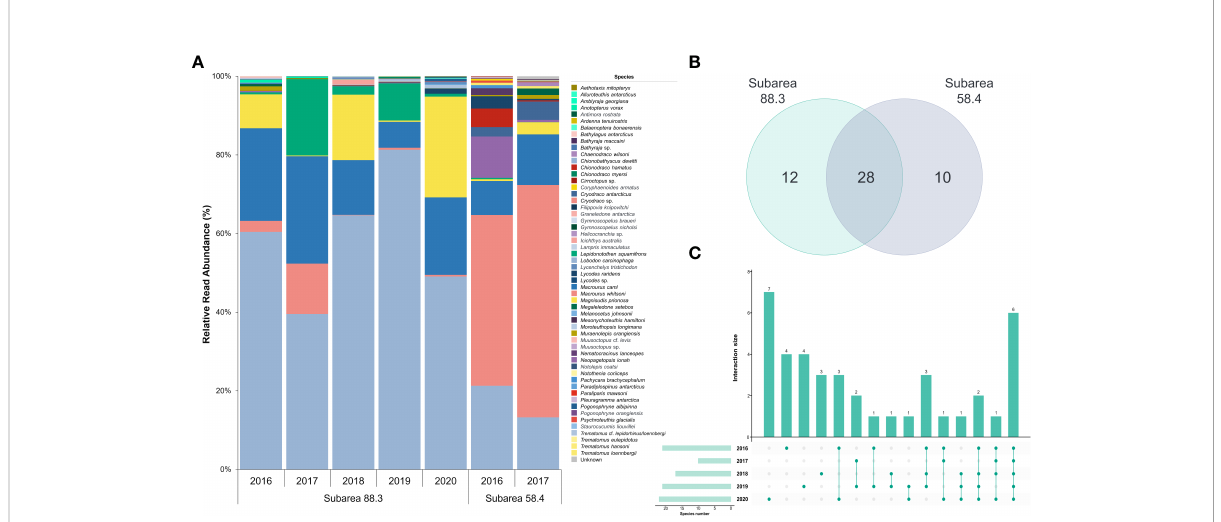
FIGURE 5 Annual prey composition and shared prey species of Dissostichus mawsoni . (A) Bar graph shows the relative read abundance of all prey species in different years and subareas. (B) Venn diagram shows the number of species identi fi ed as well as the shared prey species in both subareas. (C) Upset plot shows the number of shared prey species in subarea 88.3 for fi ve years from 2016 to